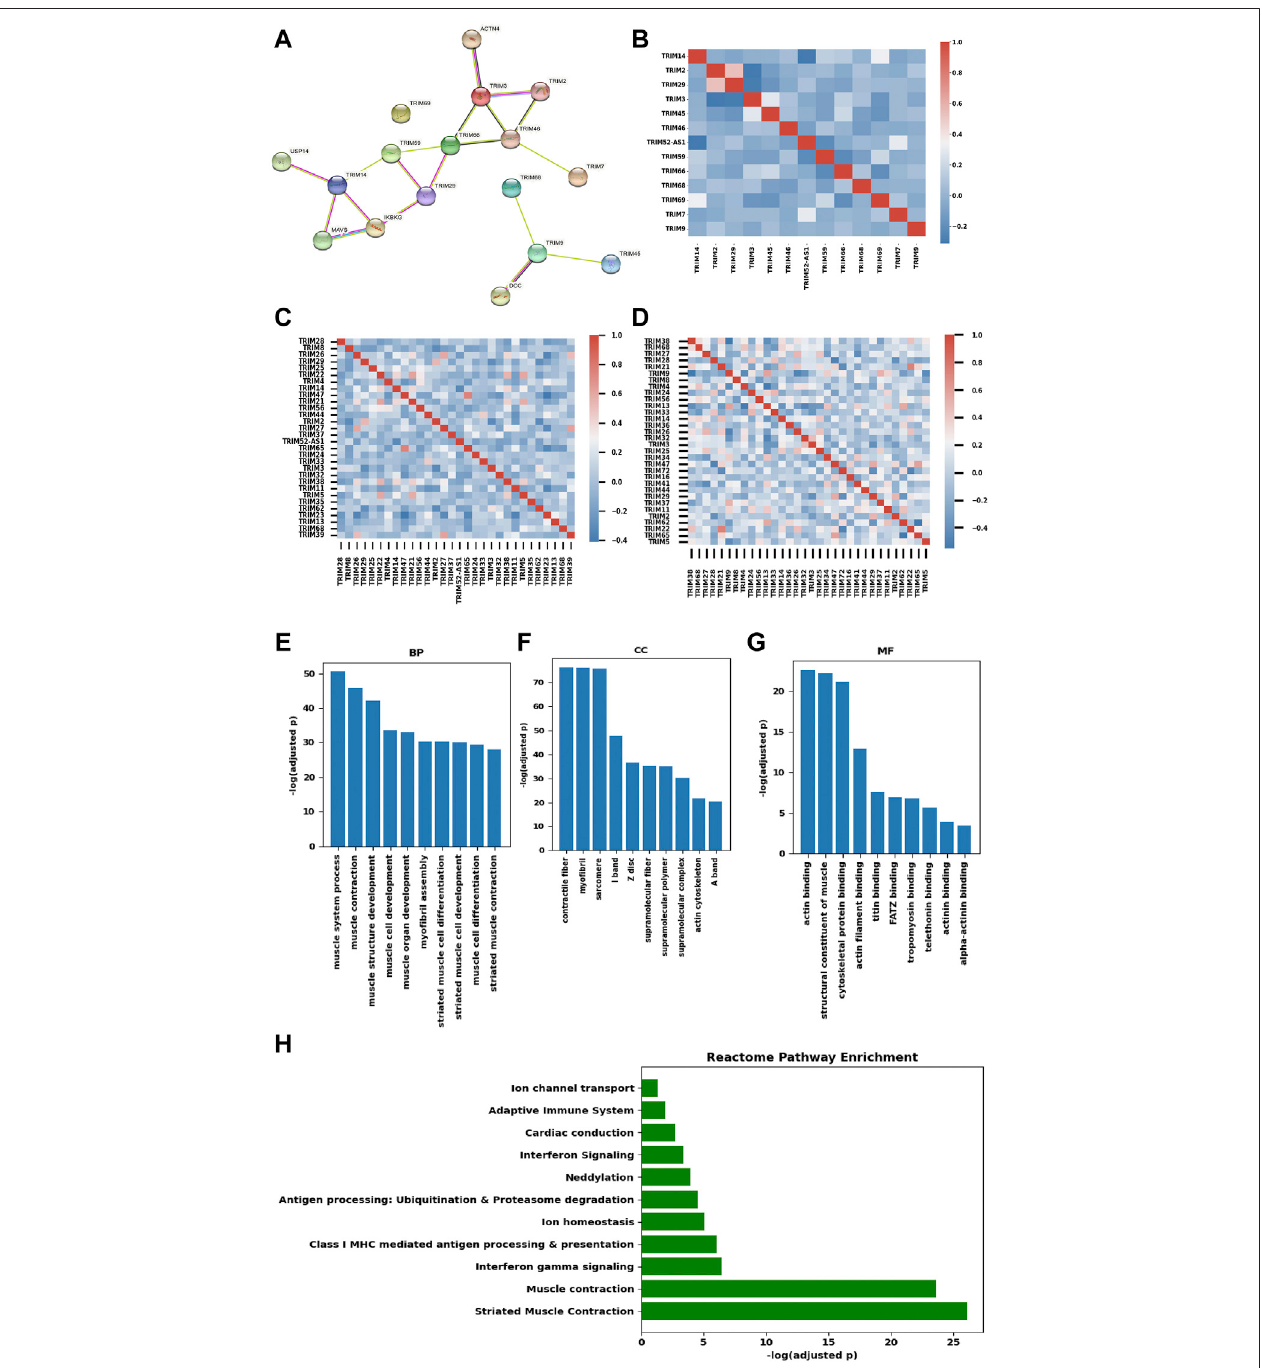
FIGURE 5 | Interaction, co-expression, and functional analysis of TRIMs. (A) the protein – protein interaction network of TRIMs generated using STRING. (B) heatmapofthePearson ’ scorrelationef fi ciencyofthe13candidateTRIMs. (C) heatmapofthecorrelationef fi ciencyoftop30expressedTRIMsinBC. (D) heatmapofthe correlation ef fi ciency of 32 TRIMs with protein expression in TCGA-BRCA cohort. (E) bar plot of the enriched biological process (BP) items. (F) bar plot of the enriched cellular component (CC) items. (G) bar plot of the enriched molecular function (MF) items. (H) Bar plot of the enriched Reactome pathways.